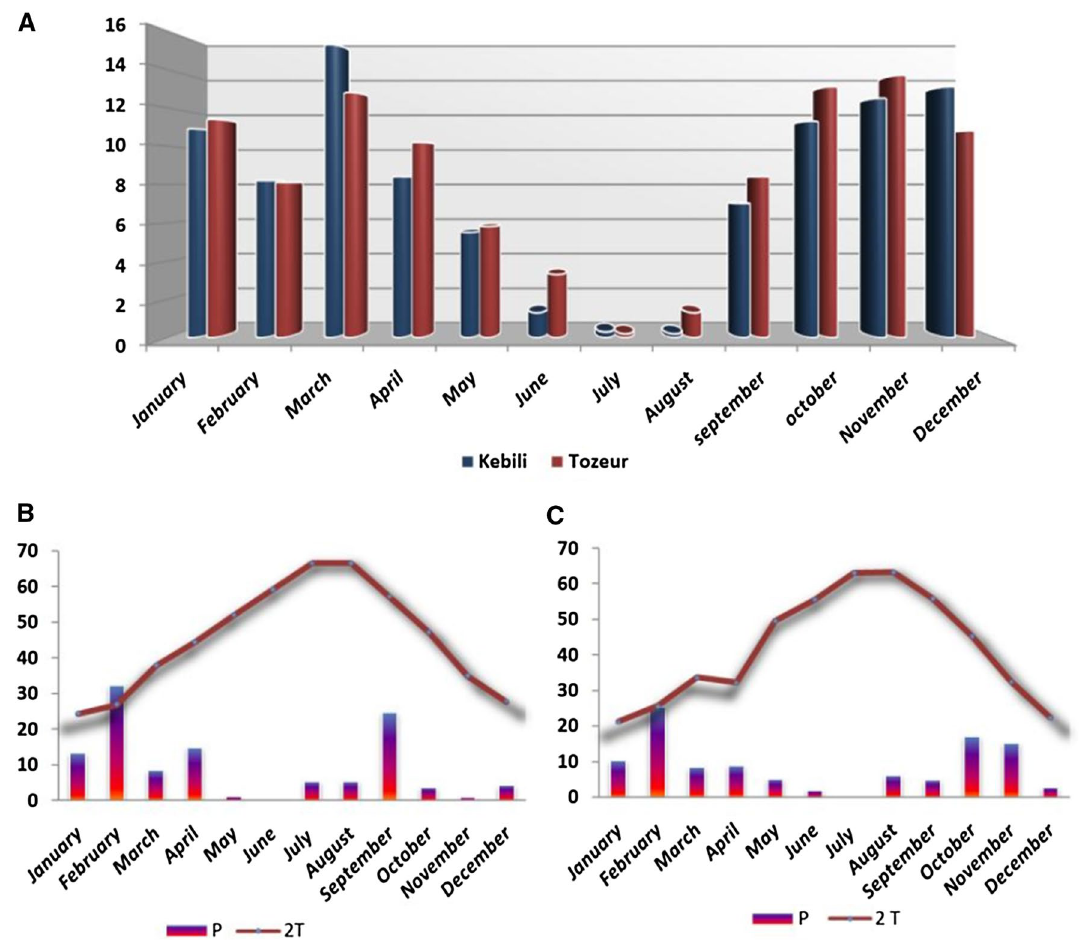
Fig. 2 Climate data of the study